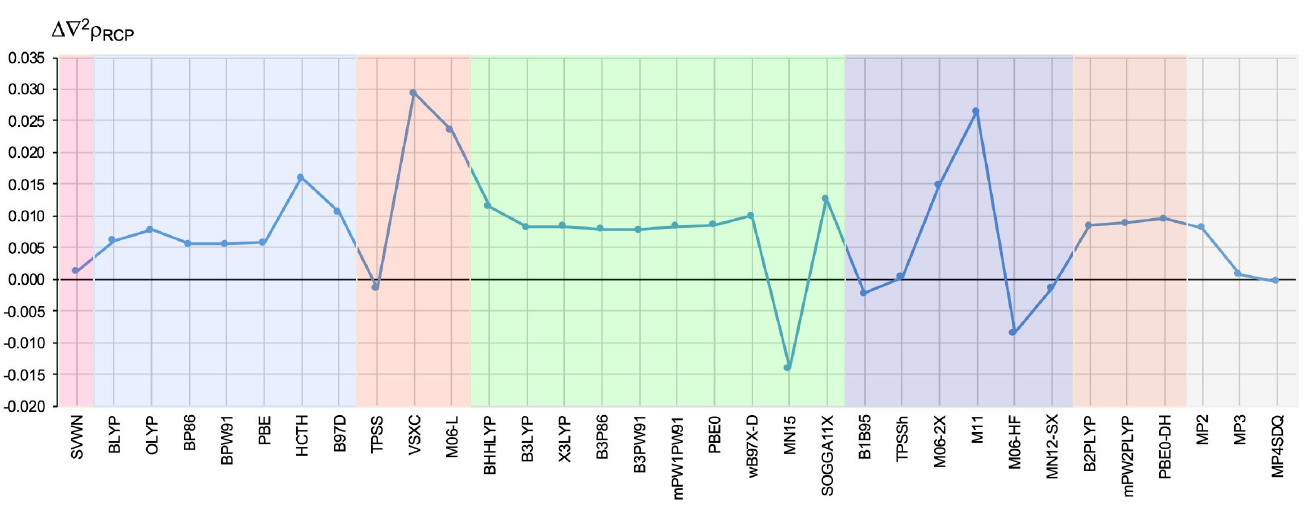
Figure 6. The difference (in relation to the CCSD method) in the value (in a.u.) of the Laplacian of the electron density determined at the ring critical point of the 2,2-dichloro-1-(1H-pyrrol-2-yl)ethan-1-one molecule. The different types of methods are represented by a colored background: LDA—pink, GGA—blue, M-GGA—orangeish, H-GGA—green, HM-GGA—violet, DH-GGA—beige, perturba- tional